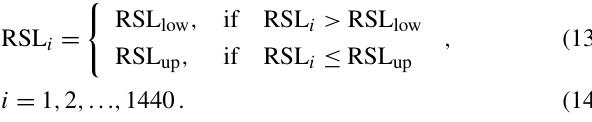
Figure 3. When the millimeter wave link length is 1km, the atten- uation caused by different water vapor densities in the frequency range of 0 to 100GHz (temperature is 15 ◦ C, and atmospheric pres- sure is